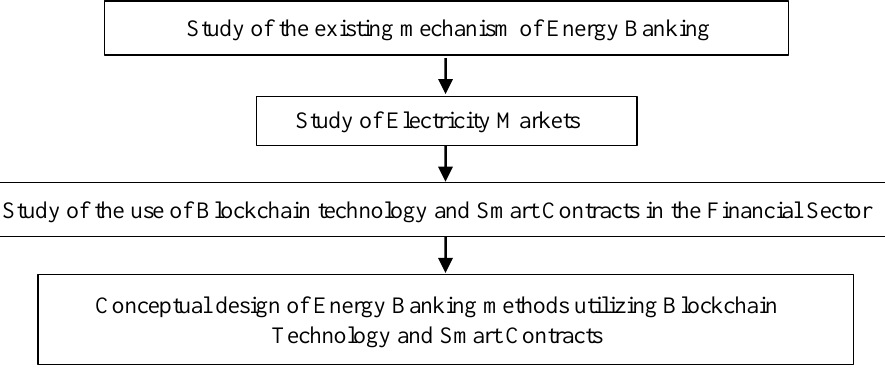
Figure 1. Flowchart showing the research methodology